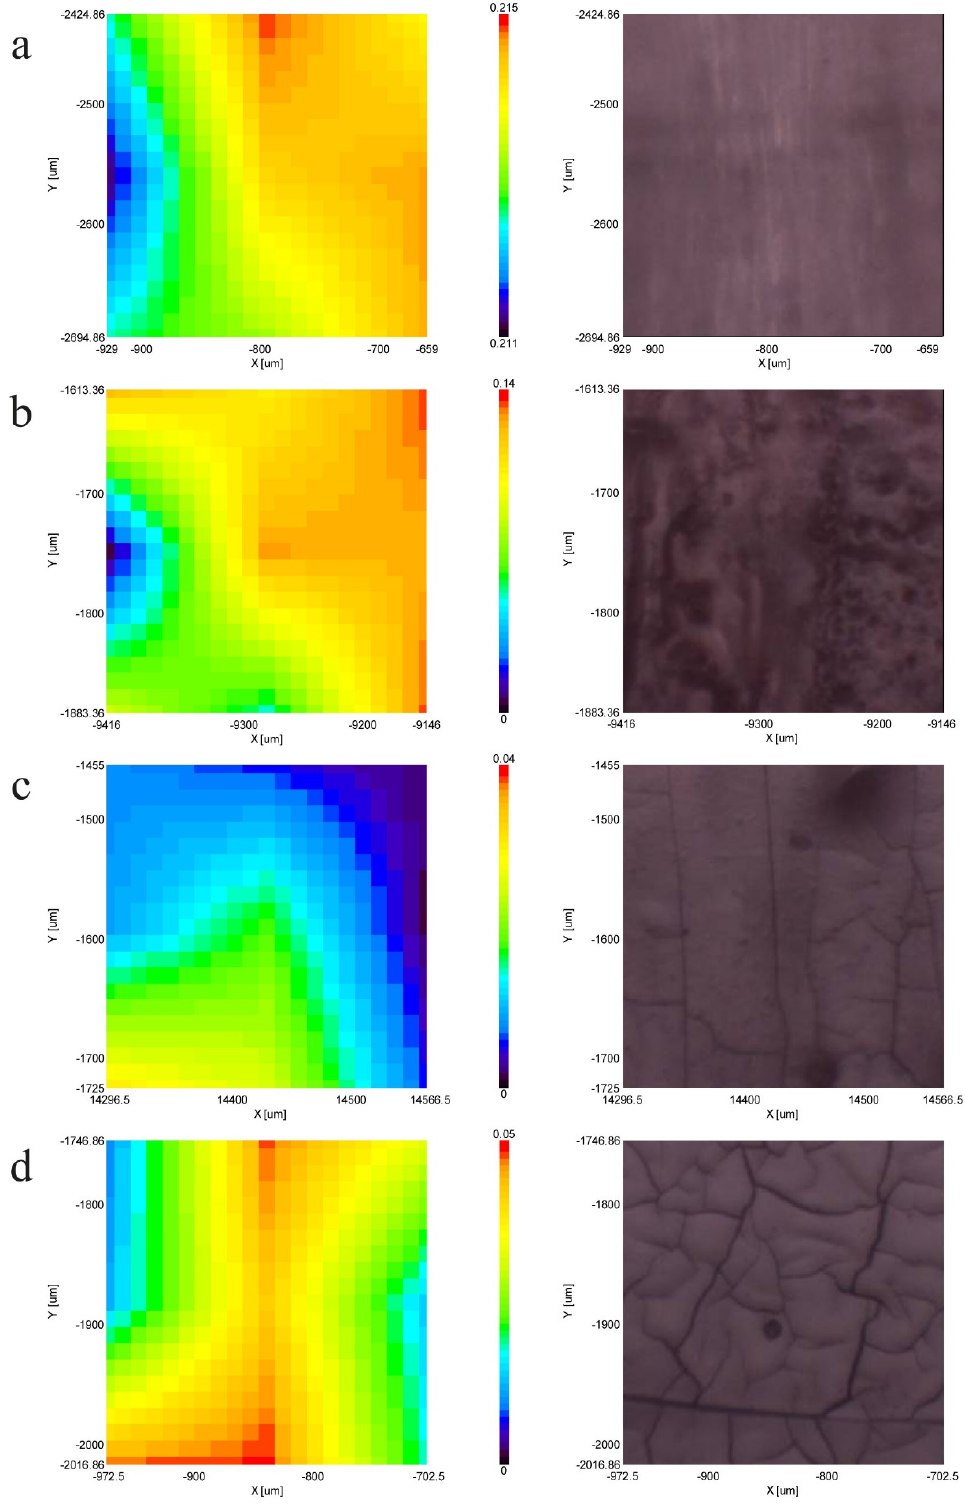
Figure 5. FTIR mapping images based on the absorbance band at 1720 cm − 1 (left) and respective microscope pictures of the measurement areas (right). ( a ) WPU-R, ( b ) WPU-3:1, ( c ) WPU-1:1 and ( d )